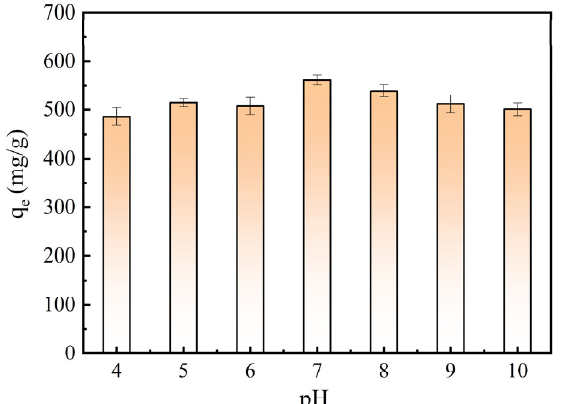
Figure 7. E ff ect of pH value on BAC adsorption properties.